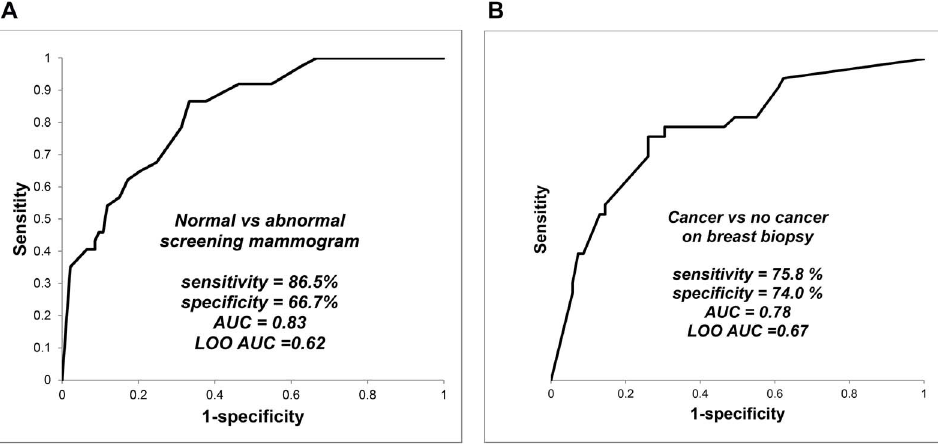
Figure 2. Breath test outcomes in screening mammography and in breast biopsy. Identification of breath biomarkers, determination of diagnostic accuracy of the breath test, and LOO cross-validation of predicted outcomes were performed in the same fashion as described in Figure 1. Sensitivity and specificity values were determined from the point on the ROC curve where their sum was maximal. The left panel displays comparison of women with normal and abnormal screening mammograms, and the right panel displays comparison of women with cancer and no cancer on breast biopsy.